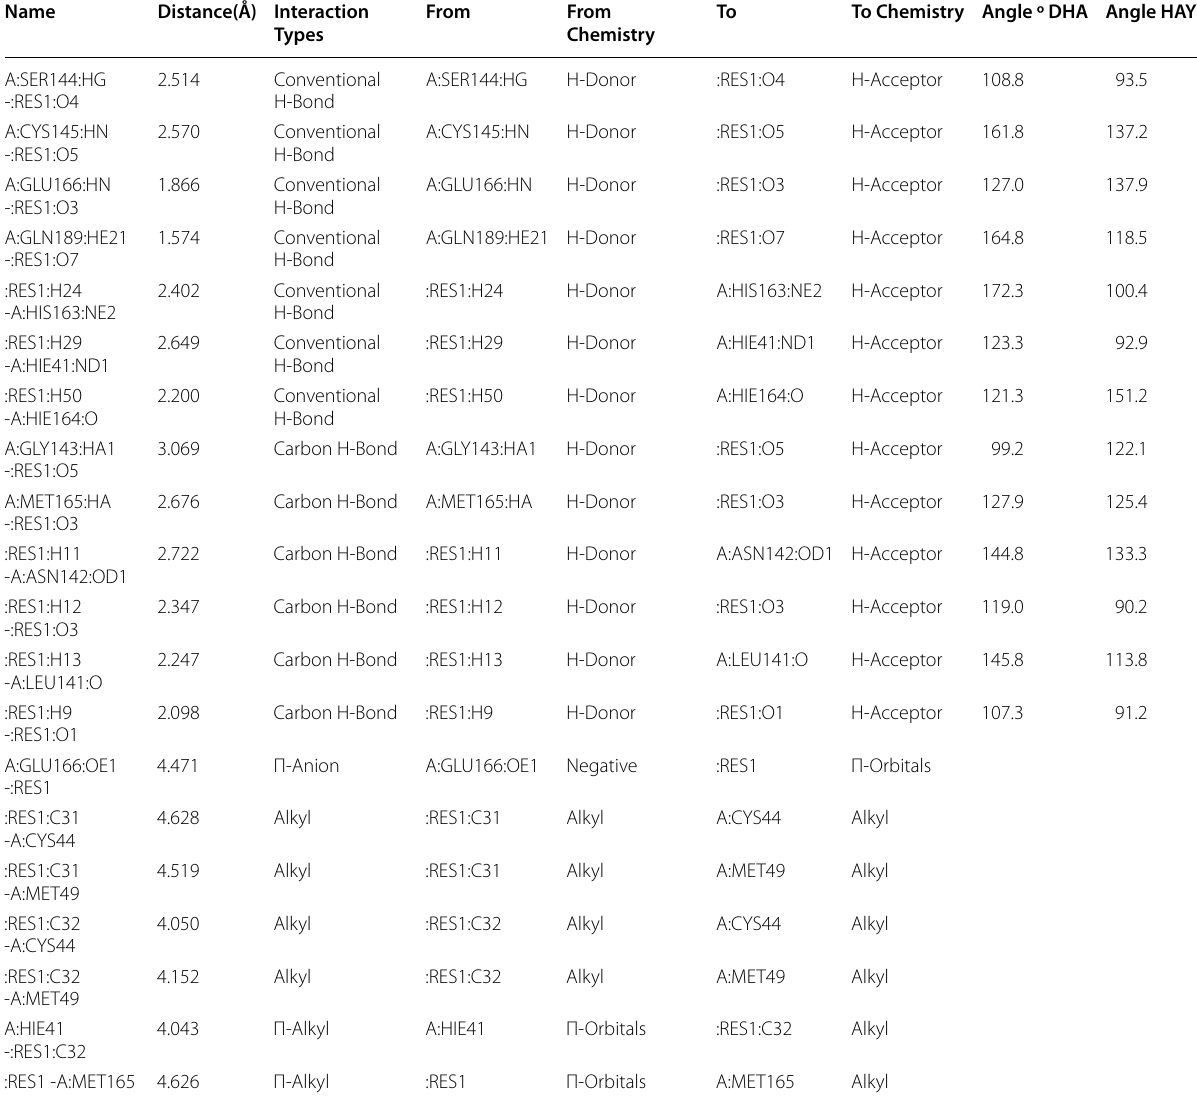
Table 7 Interaction types with surrounding amino acids of SARS CoV 2 Main Protease (PDB ID: 6XBH) with inhibitor Index number 847 Name Distance(Å) Interaction From From Types Chemistry